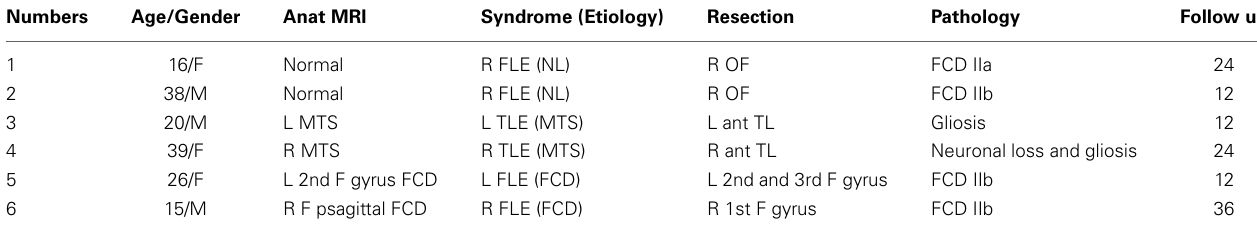
Table 1 | Patients’ clinical